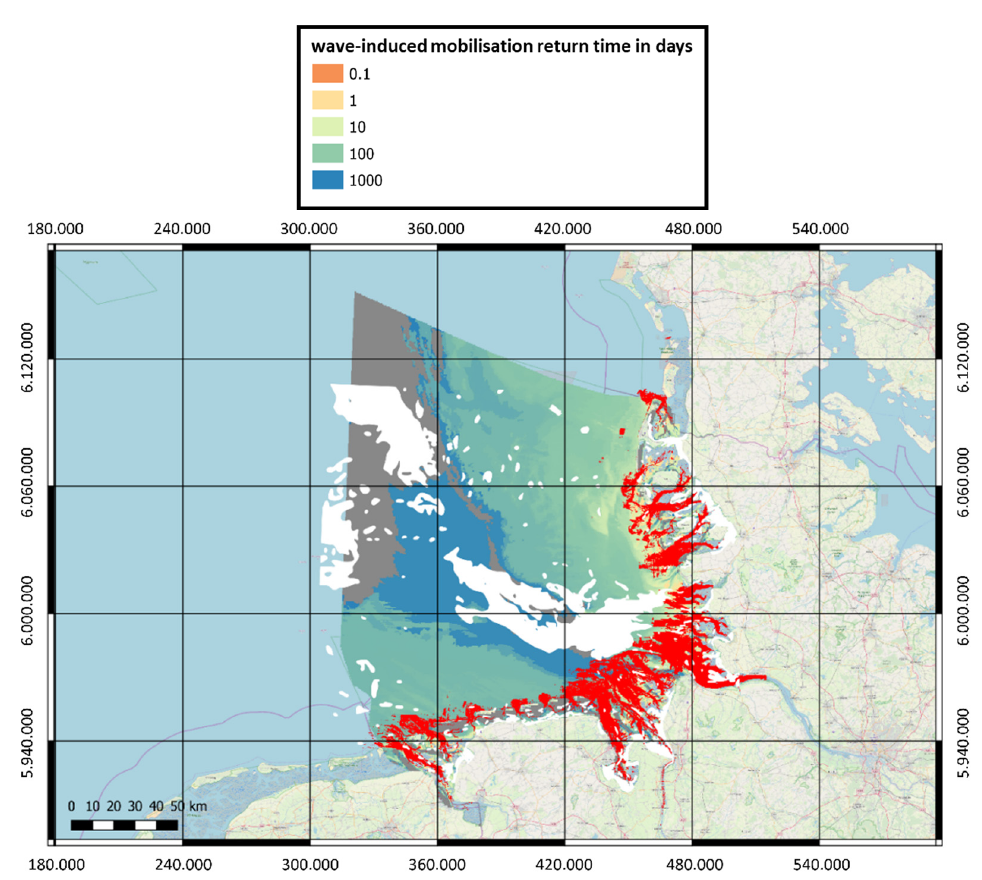
Figure 9. Return period map for wave-induced mobilization of the British 250-pound General Purpose Bomb in EPSG:25832-ETRS89/UTM Zone 32 N. The red areas represent regions of sediment erosion greater than D/2 for this object.